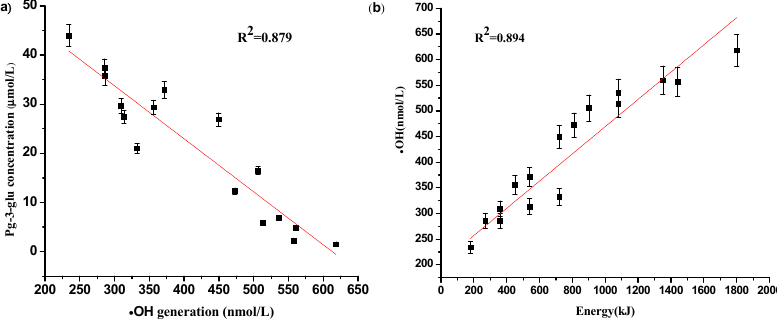
Figure 4. Correlation analysis between ( a ) •OH production and Pg-3-glu concentration and ( b ) total ultrasonic energy output and ∙ OH production.